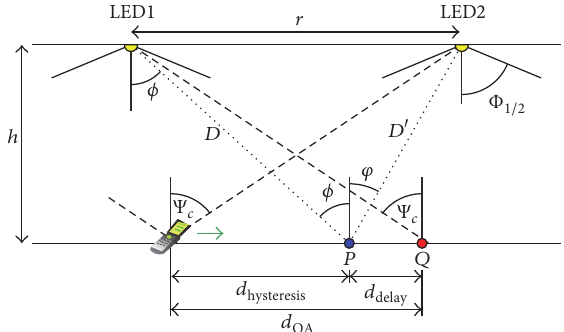
Figure 4: The view overlap distance of two LEDs.